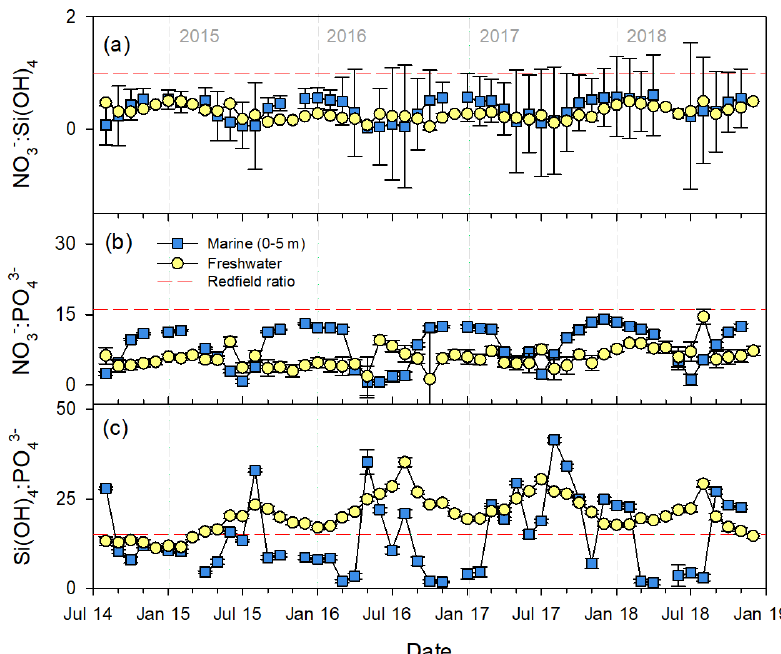
: Si ( OH ) : PO 3 − : PO 3 − (b) , and NO − (c) across 4 (a) , Si ( OH ) 4 3 4 3 4 : Si ( OH ) 4 ratios due to large variability that masks the seasonal pattern. 3